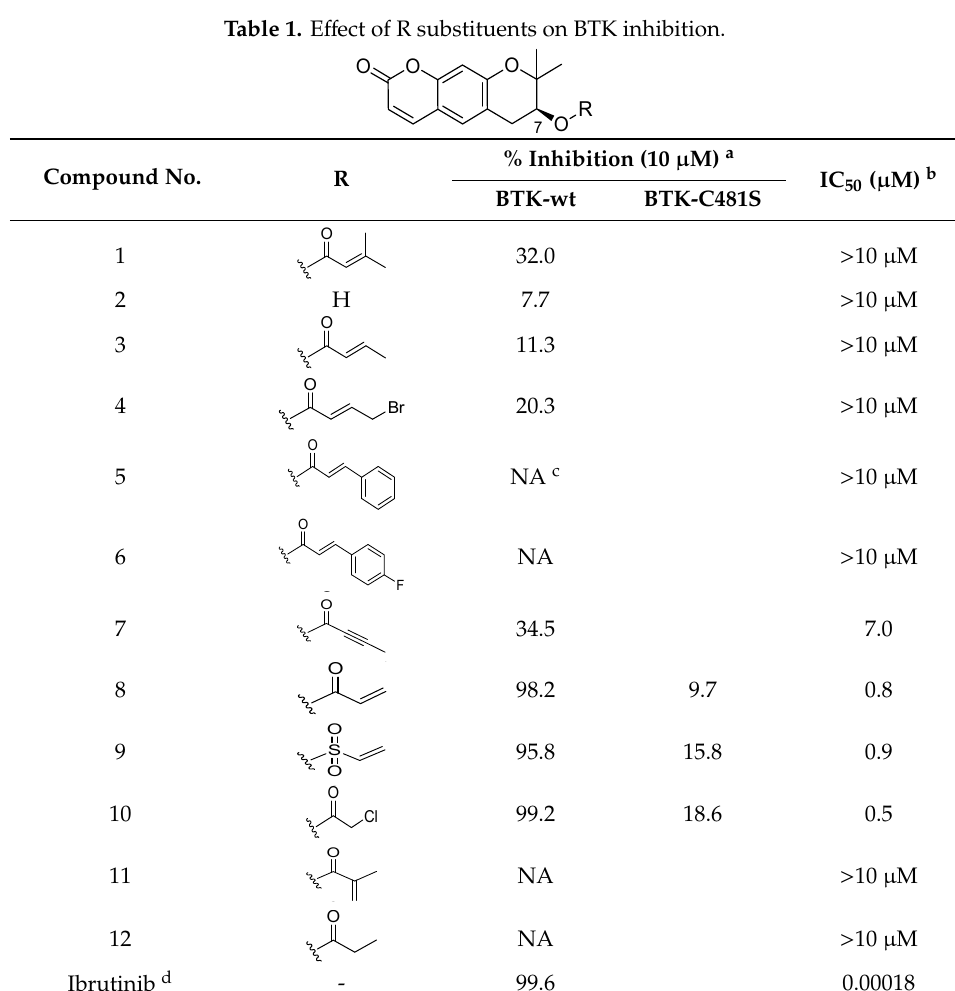
a Percentage BTK inhibition was determined and compared with that of the negative control (DMSO) at 10 µM. The values represent the mean values of two separate experiments. b The IC 50 values were calculated using GraphPad Prism version 5.0. c NA indicates not active at 10 µM. d Ibrutinib as a positive control.